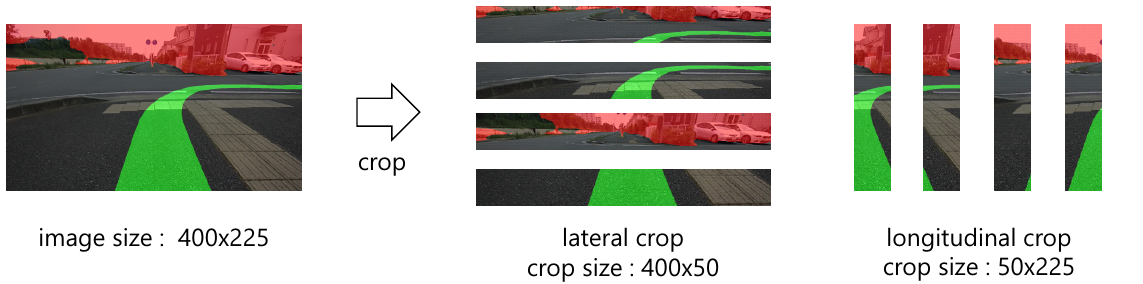
Figure 8. Example of image cropping to prevent over-fitting for position and shape of recommended area (green